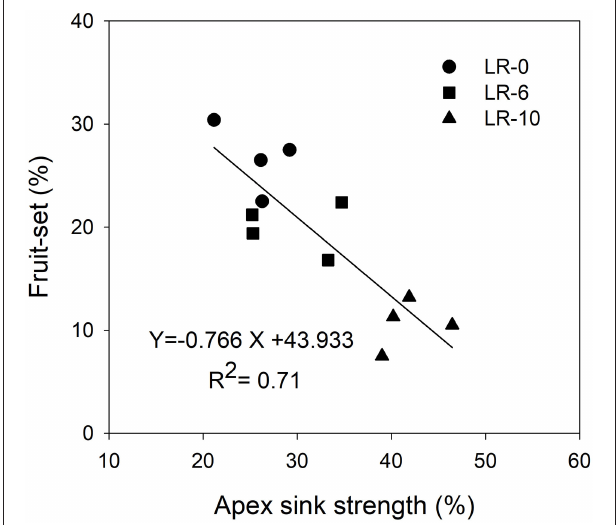
FIGURE 7 | Linear regression between shoot apex sink strength and cluster fruit-set at harvest. Shoot apex sink strength was calculated as the mean of 13 C percentage allocation during the pulsing study (from 7 to 14 days after bloom).